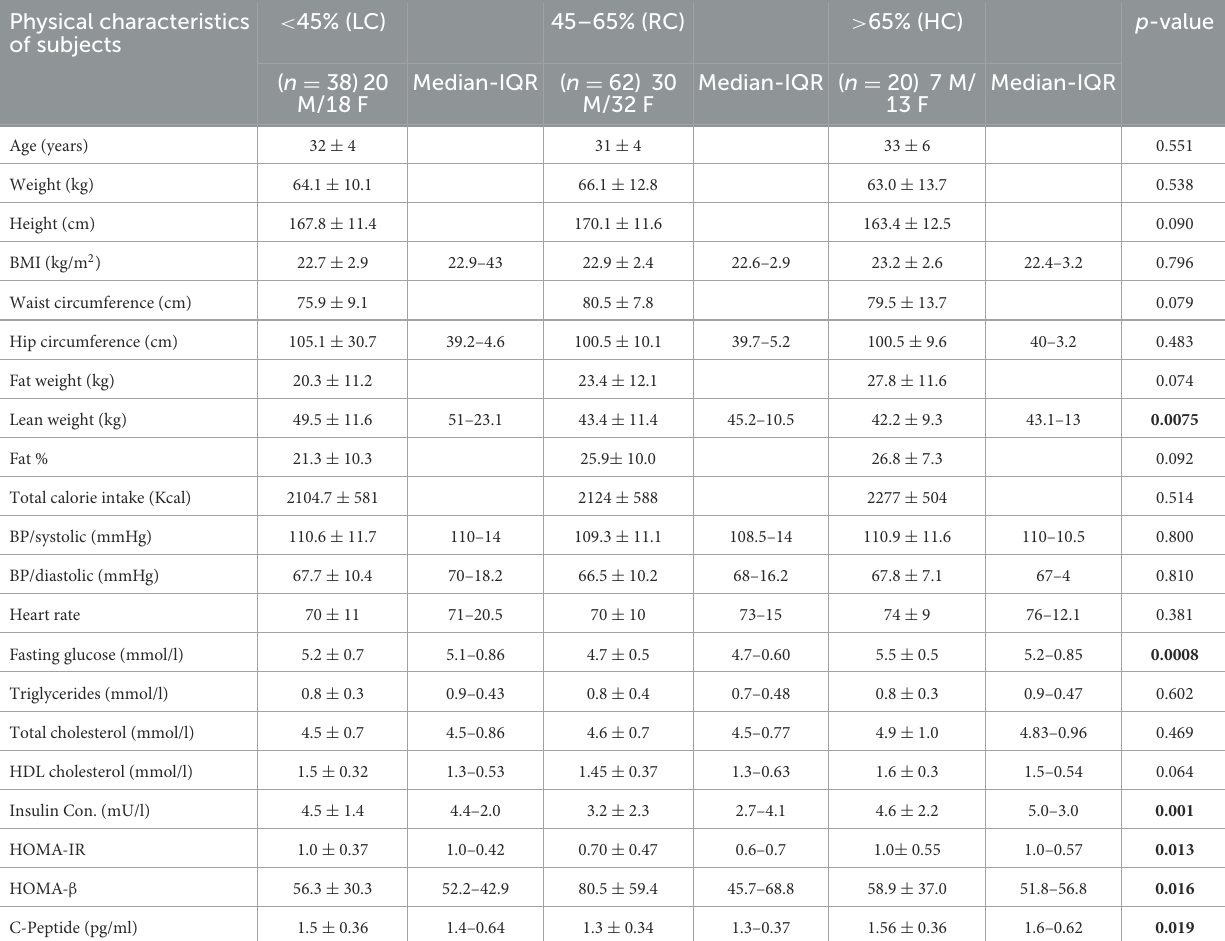
TABLE 1 Differences between groups based on daily calorie intake (%) from carbohydrates. Physical characteristics of